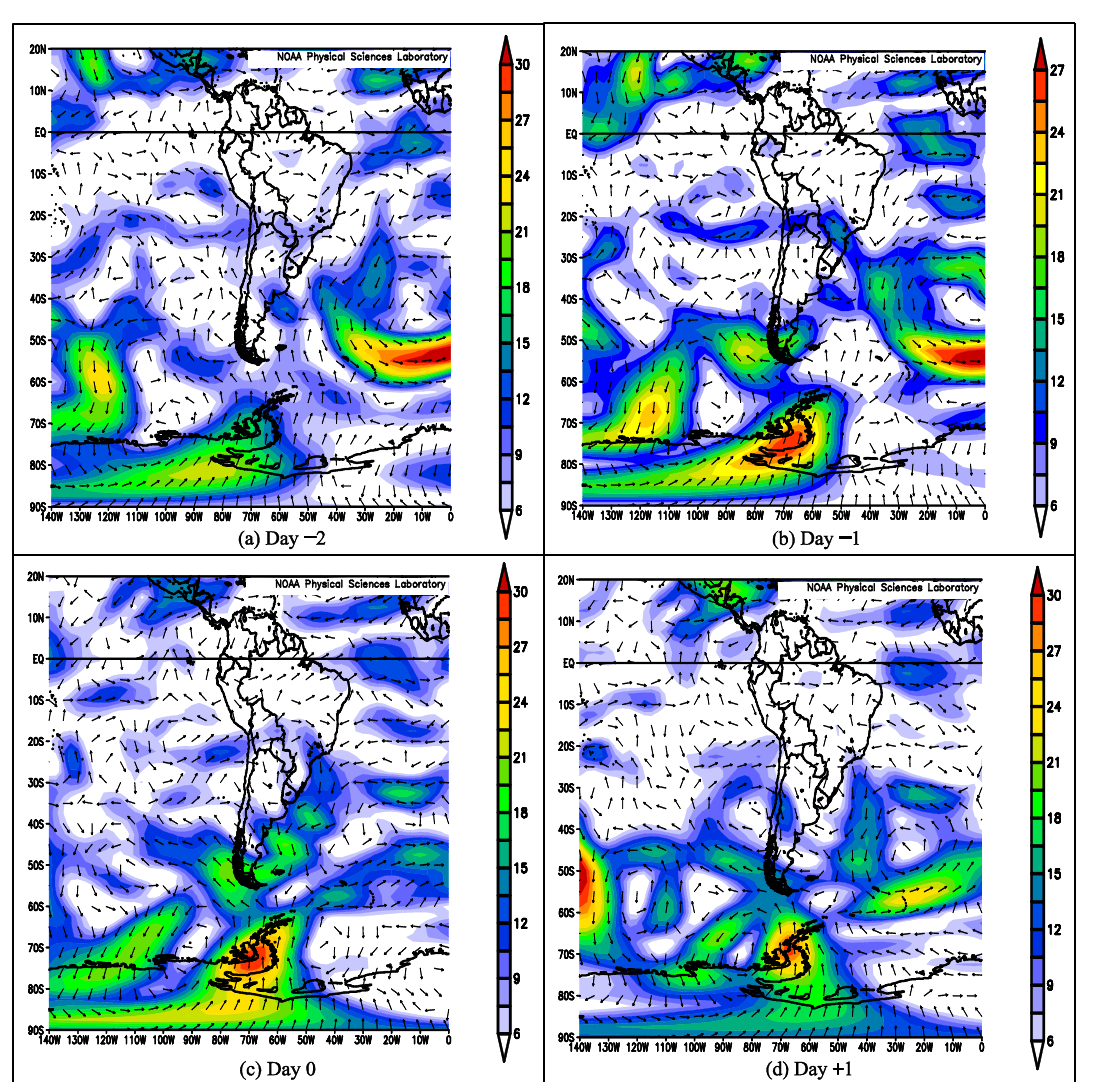
Figure 13. Wind composite anomaly (m/s) at mid levels of the atmosphere (500 hPa) for ( a ) day −2, ( b ) day −1, ( c ) day 0, and ( d ) day +1 of the rainfall event on 15 January 1970. Source: NOAA/ESRL Physical Sciences Laboratory. The climatology base period is 1980 – 2010.